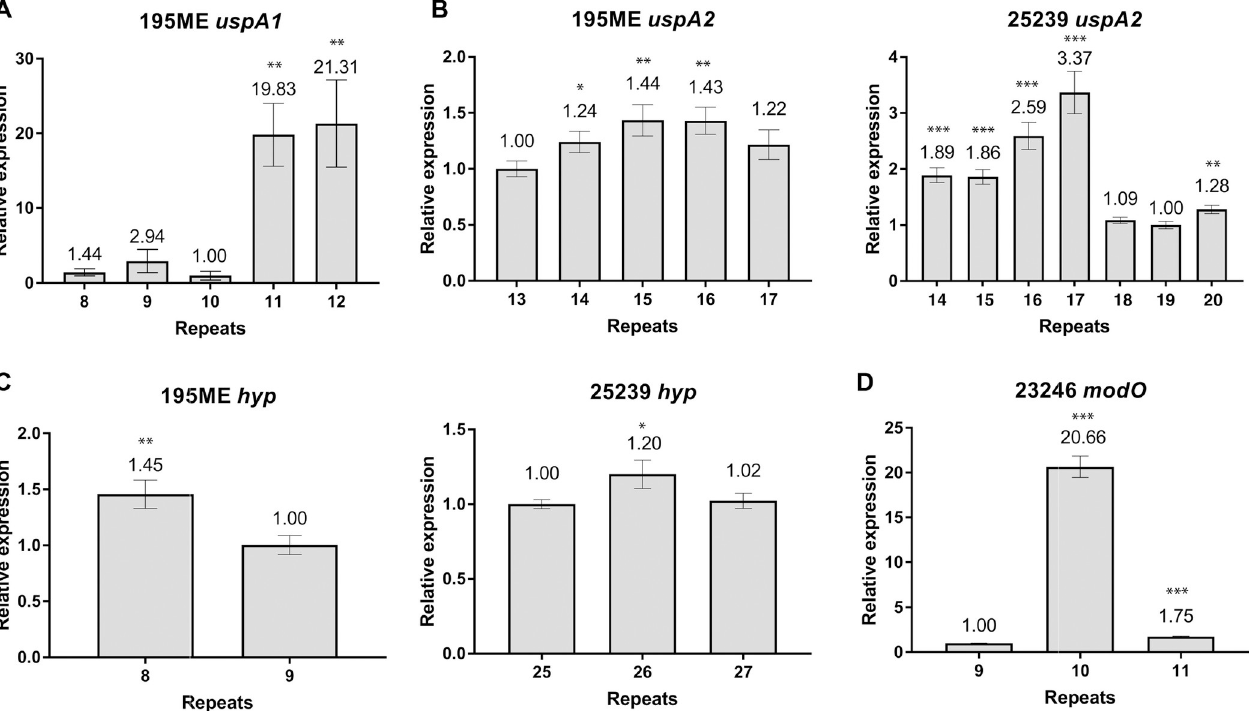
Fig 2. Gene transcript levels relative to DNA repeat tract sizes. Relative differences in mRNA levels measured by qRT-PCR for A) uspA1 , B) uspA2 , C) hypothetical permease MC25239_RS00020, and D) modO . Fold-change is calculated relative to the variant with the lowest expression (set as 1.00), and values are shown above the bars. P-values were calculated using a two-tailed Student’s t-test comparing mRNA levels relative to the variant with the lowest mRNA (set at 1.00). � , P < 0.05 �� , P � 0.01, ��� , P � 0.001.